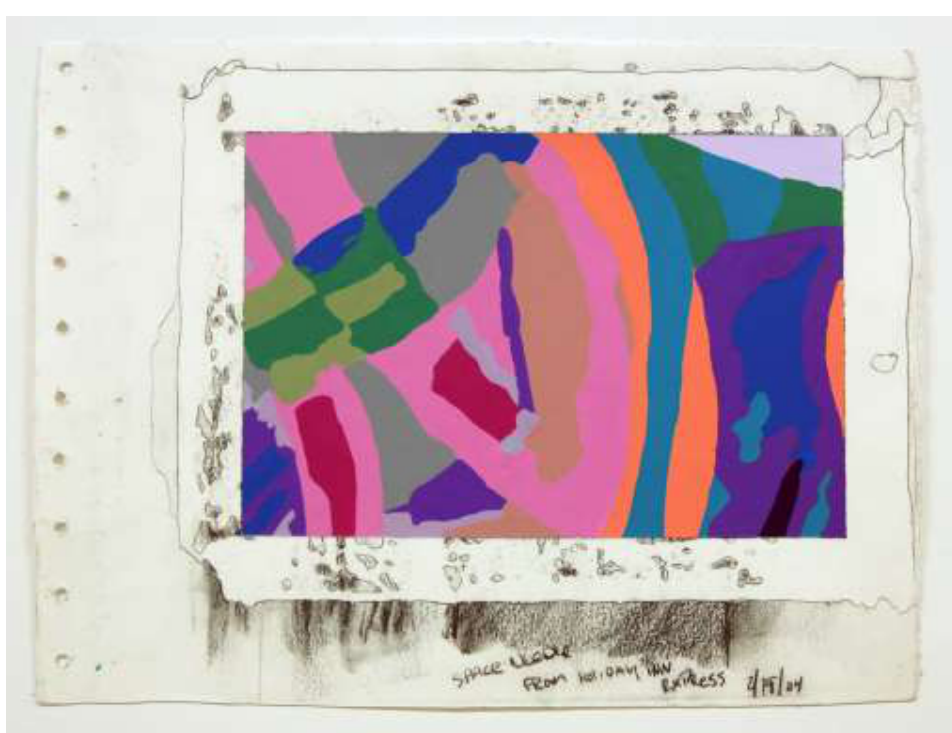
Figure 5 Steven Pearson, Sketchbook Revisions: Space Needle , 2014, charcoal, graphite, and acrylic on Rives BFK, 12 x 9